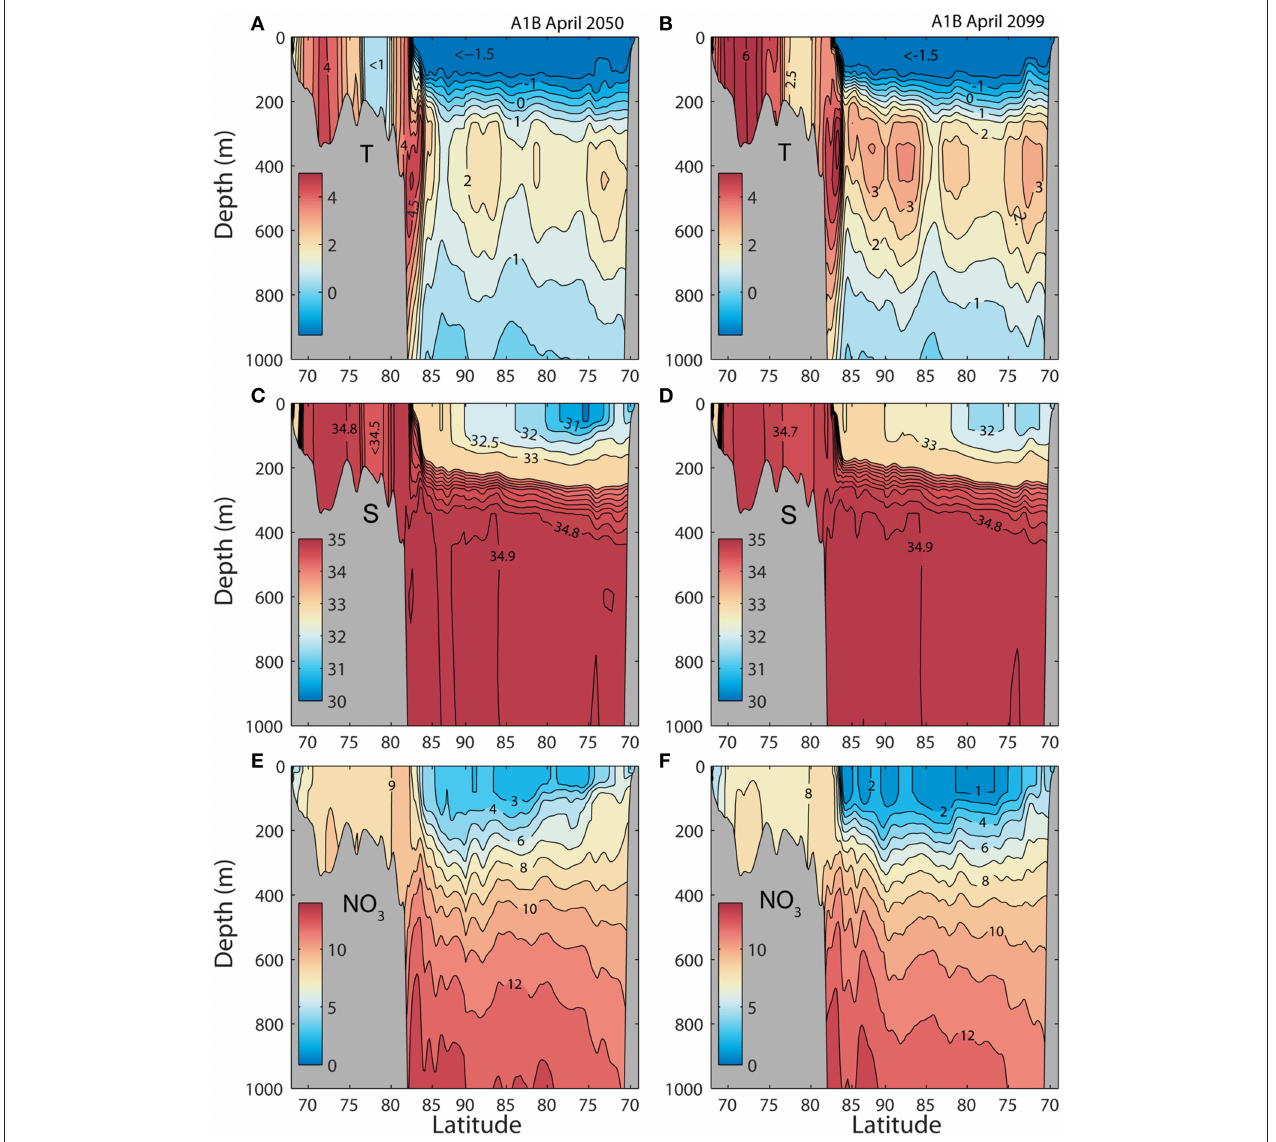
FIGURE 5 | Simulated monthly mean temperature ( ◦ C), salinity (psu), and nitrate (mmol N m − 3 ) for April along section A from the southern Barents Sea to the Beaufort Sea (see Figure 2). Forced by a A1B scenario. (A,C,E) April 13 in 2050. (B,D,F) August 16 in